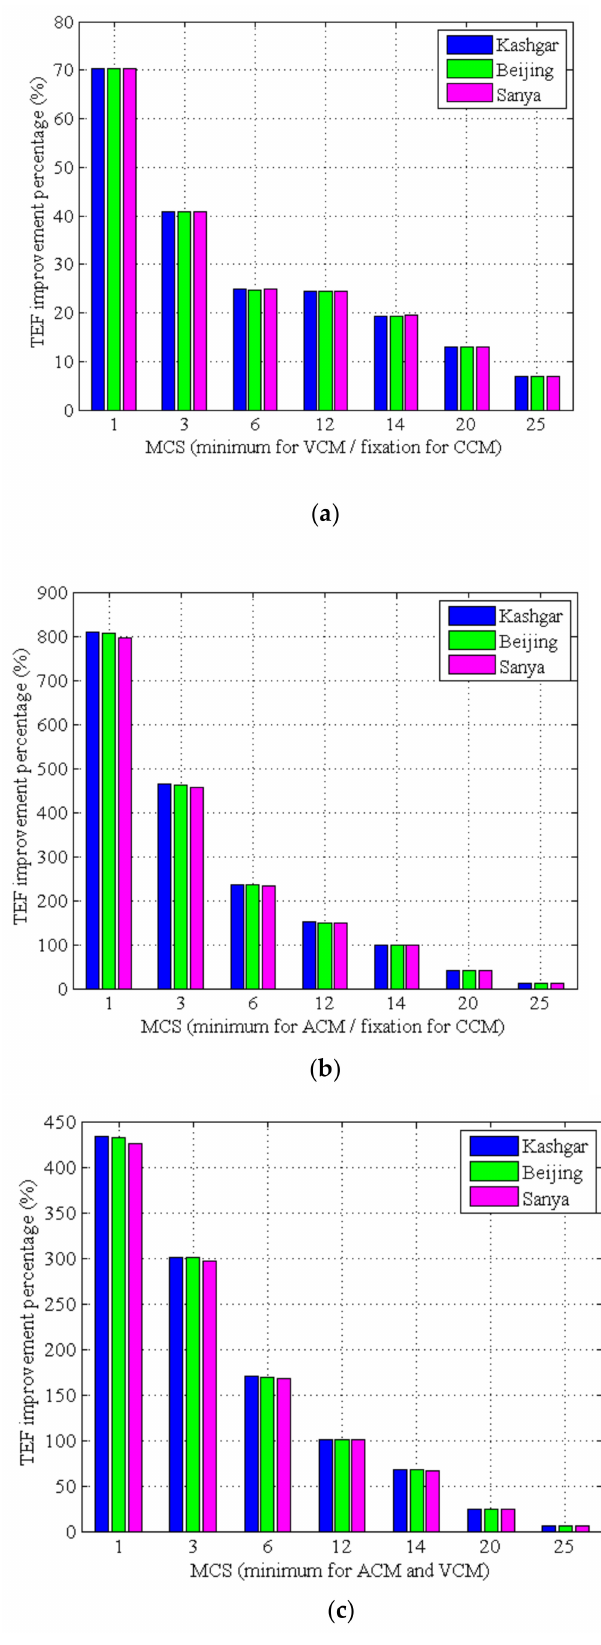
Figure 9. TEF improvement percentage. ( a ) VCM vs. CCM; ( b ) ACM vs. CCM; ( c ) ACM vs.